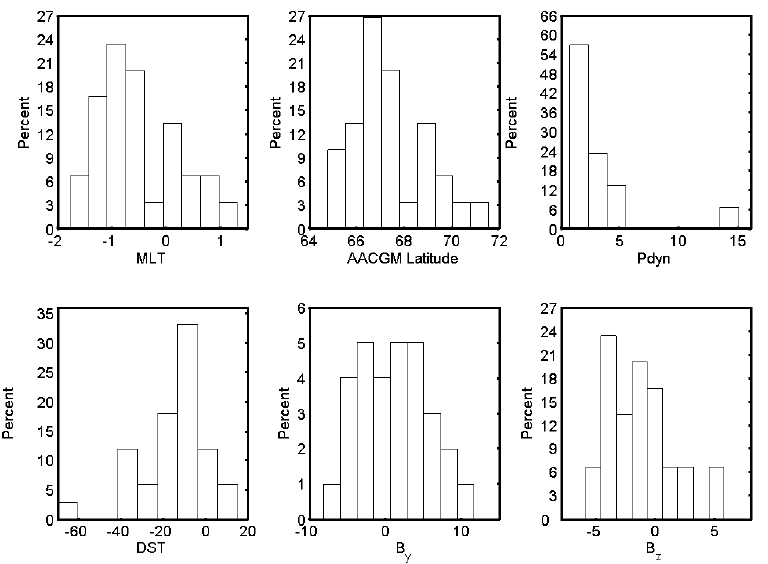
Fig. 4. Histograms showing the distribution of data for various parameters. Abscissas are percent of total number of events.